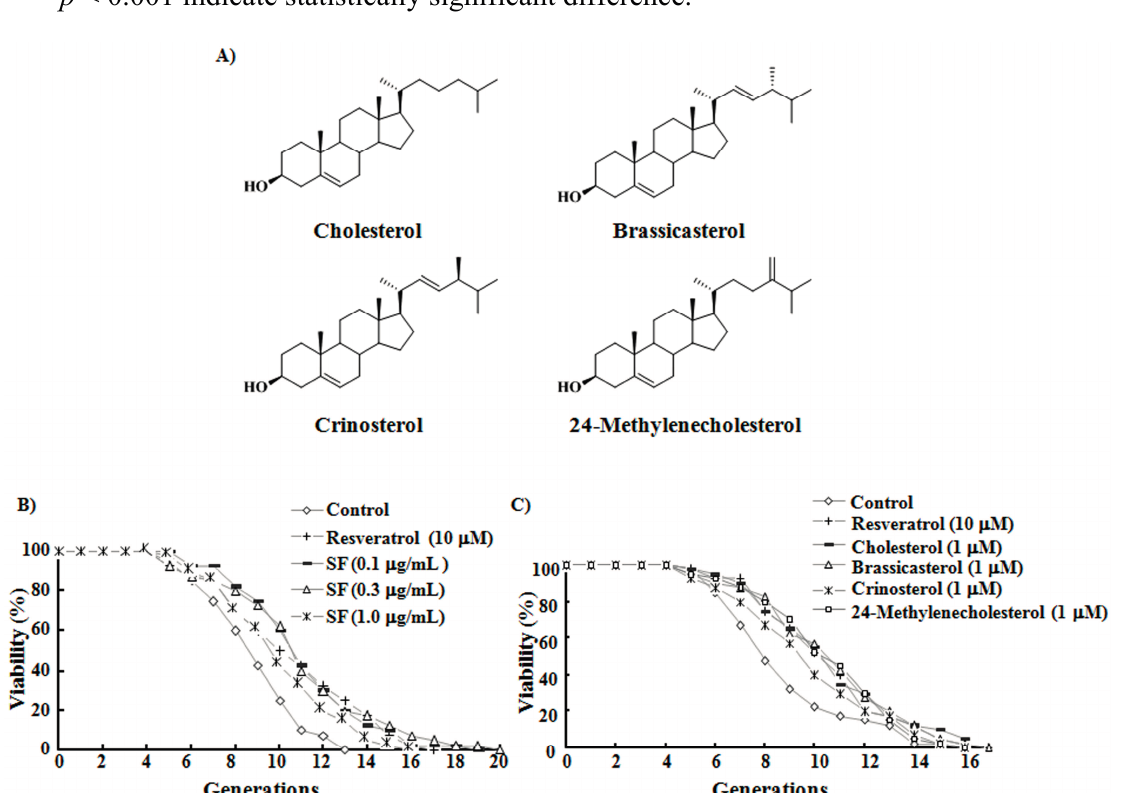
Figure 1. Anti-aging activities of sterol fraction (SF) and the four sterol compounds obtained from this fraction and their respective chemical structures. ( A ) Chemical structures of the four sterol compounds; ( B ) Effects of SF on the replicative lifespan of K6001 yeast. In the replicative lifespan assay, 4000 cells were spread on glucose agar plates. Daughter cells of 40 microcolonies in each plate were counted. The average lifespan of the K6001 control group was 8.0 ± 0.34 generations; resveratrol at 10 μ M, 9.7 ± 0.53 **; SF at 0.1 μ g/mL, 10.3 ± 0.46 ***; SF at 0.3 μ g/mL, 10.2 ± 0.56 **; SF at 1 μ g/mL, 9.2 ± 0.43 *; ( C ) Effects of the four sterols on the replicative lifespan of K6001. The average lifespan of the K6001 control group was 8.0 ± 0.43 generations; resveratrol at 10 μ M, 9.7 ± 0.44 **; cholesterol (CHOL) at 1 µM, 9.9 ± 0.47 **; brassicasterol at 1 µM, 9.9 ± 0.47 **; crinosterol at 1 µM, 10.0 ± 0.46 **; 24-methylenecholesterol at 1 µM, 9.8 ± 0.43 **. * p < 0.05, ** p < 0.01, and *** p < 0.001 indicate statistically significant